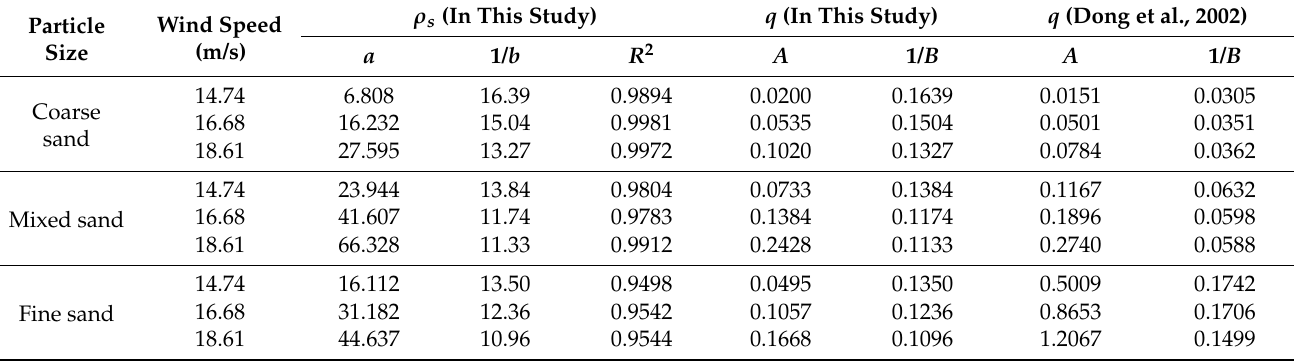
Table 2. The regression coefficients of the sand transport rate and sand concentration.